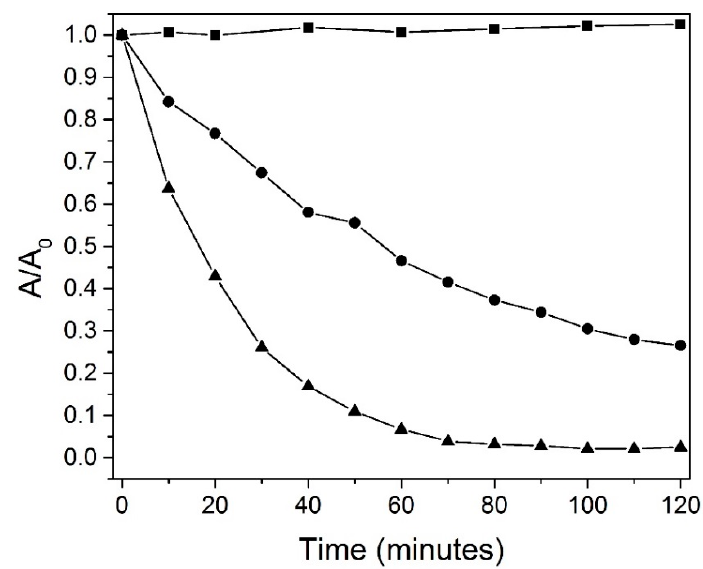
Figure 10. The degradation of RhB at pH = 3 is expressed by the A/A 0 ratio in the dark (marked with ● ), under solar irradiation (marked with ▲ ) in the presence of a catalyst, and under solar irradiation without a catalyst (photolysis, marked with ■ ).